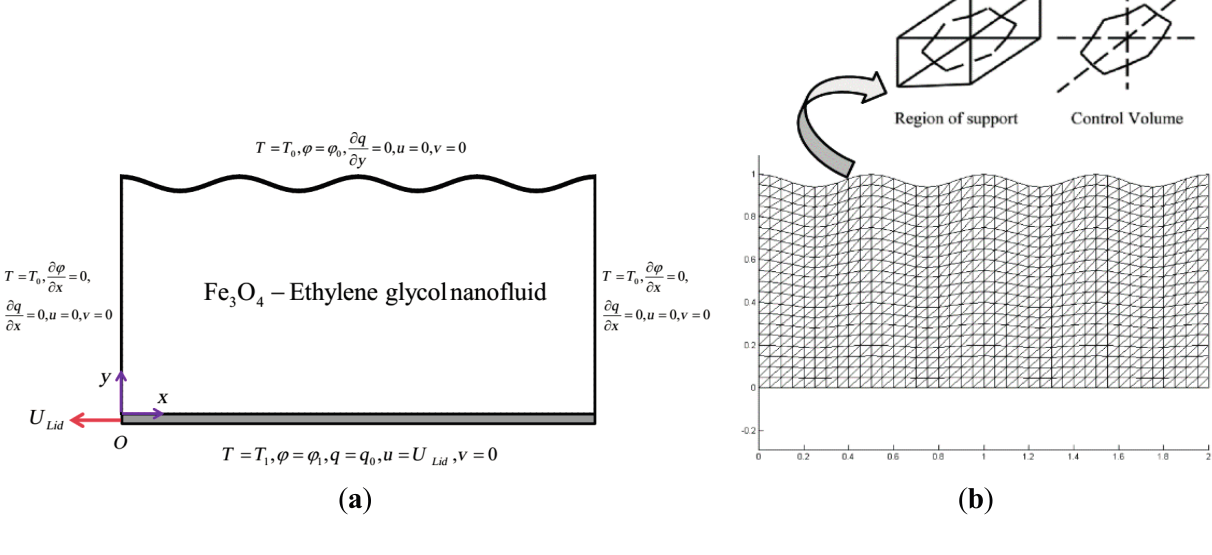
Figure 1. ( a ) Geometry of the problem and boundary conditions; ( b ) the mesh of enclosure considered in this